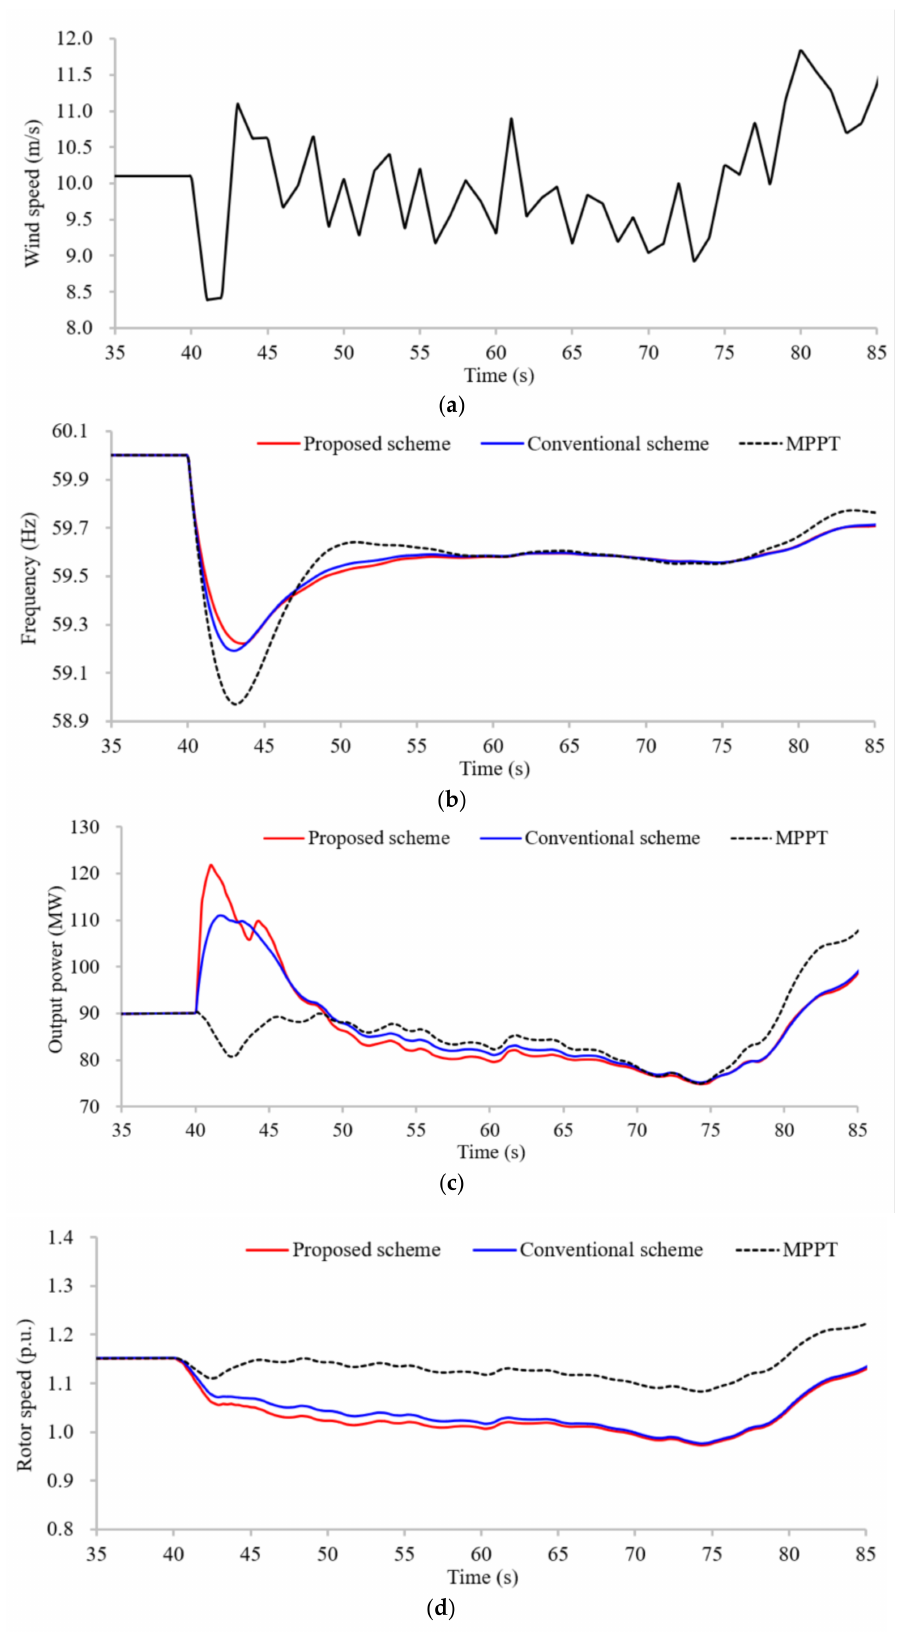
Figure 9. Simulation results for Case 4: ( a ) Wind speed; ( b ) System frequencies; ( c ) Active power of the DFIG; ( d ) Rotor